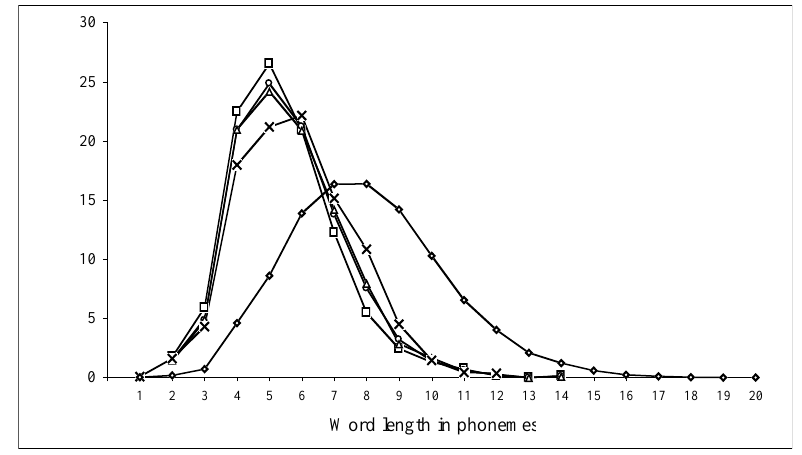
Figure 1. Percentage of words as a function of length in the Viana (3-, 4-, and 5-year-old), Ramos-Pereira (R-P; 1- to 2-year-old), and Porlex (adult)